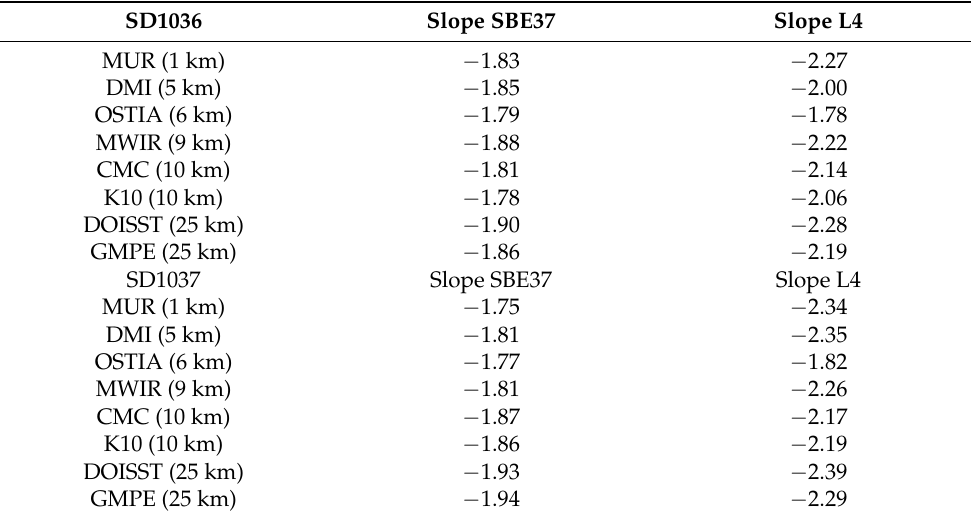
Table 4. Spectral slopes for the GHRSST L4 data and the corresponding sensor on saildrone 1036 and 1037.